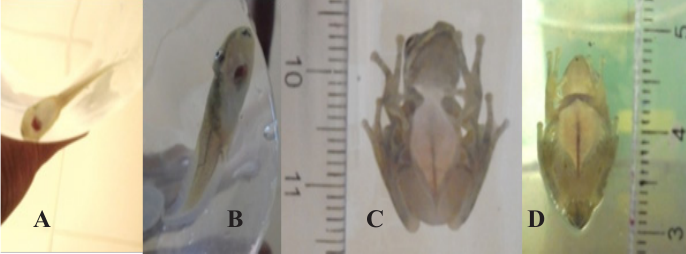
Figure 6: Tadpoles and metamorphs of P. cruciger exposed to cercariae type C at Gosner stage 27/28. A and B) infected tadpole with a hole on the belly region in different stages of tadpole stage; C) uninfected metamorph; D) same infected metamorph; the hole developed into a stripe at the metermorphosis at 30/31 (A), 36 (B), 44/45 (D) Gosner stage, Complete metermorphosis (C).